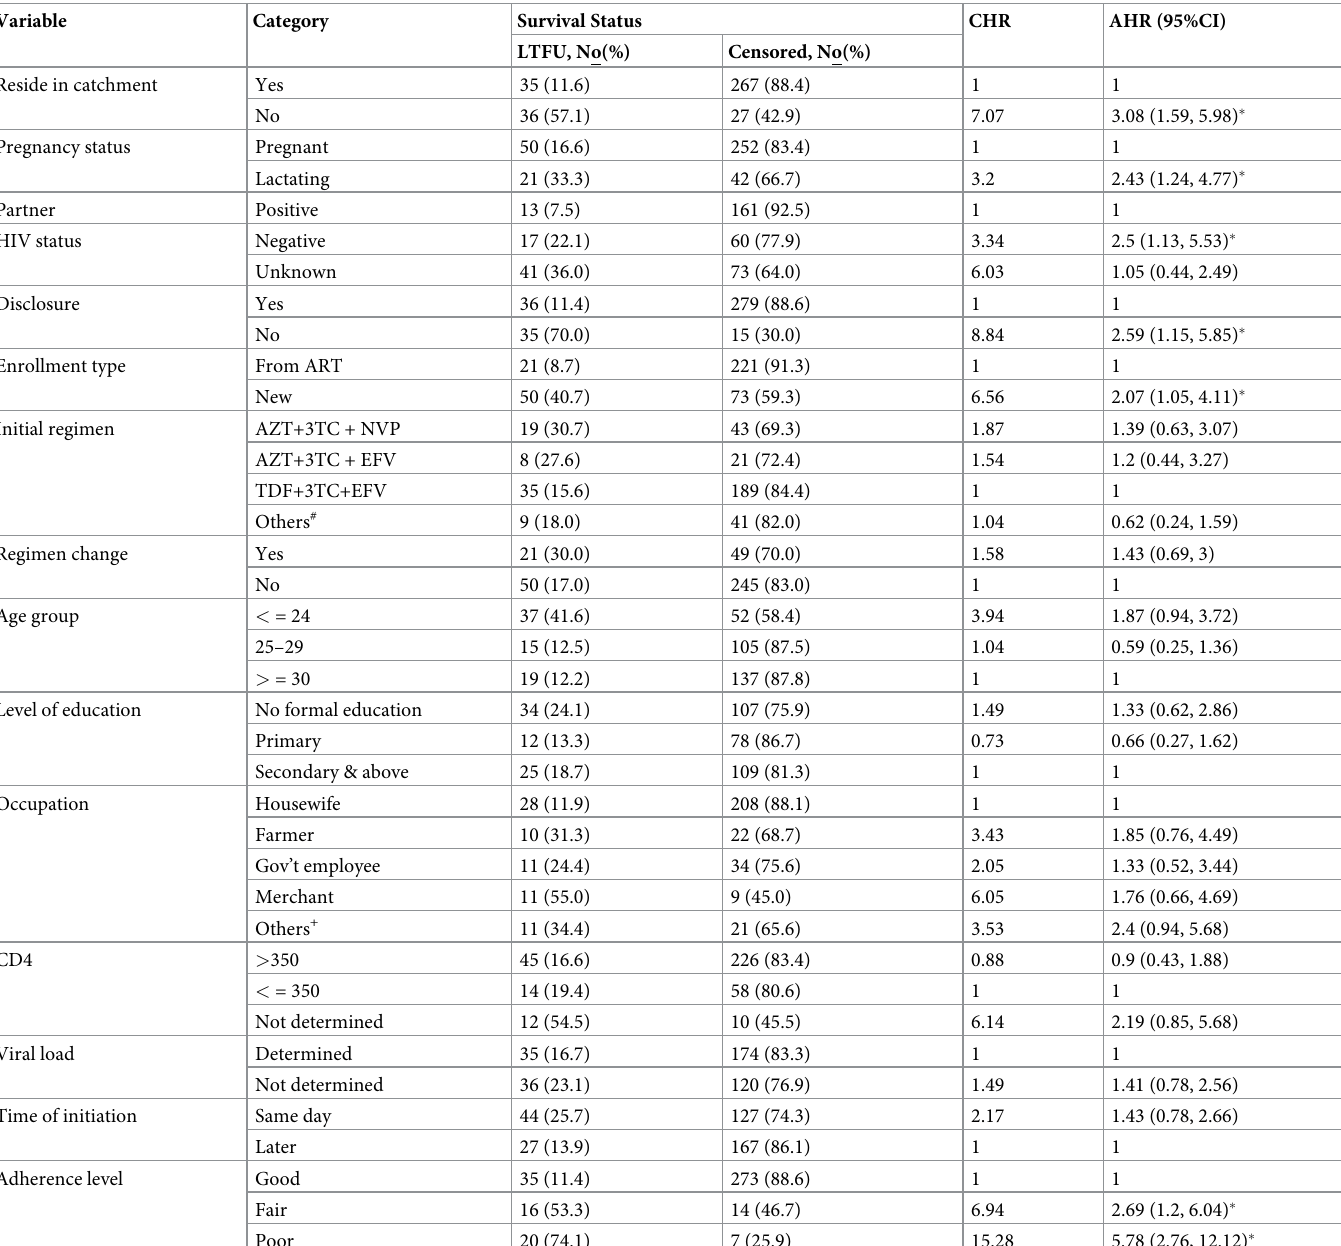
Table 4. Predictors of LTFU among women on Option B+ PMTCT program in Pawi district health facilities, northwest Ethiopia, June 2013- March 2021. Variable